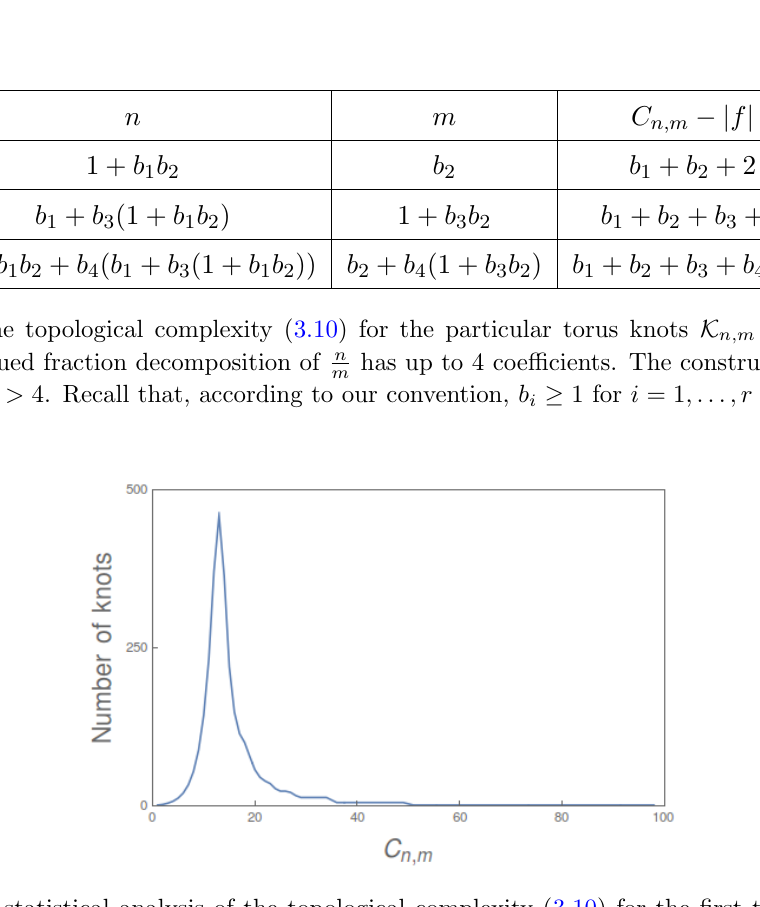
Figure 5. A statistical analysis of the topological complexity (3.10) for the (cid:12)rst three thousand torus knots (as told by their crossing number), ignoring the framing contribution. While the crossing number of knots in the sample reaches up to 10 4 , C n;m increases much more slowly, reaching a maximum of 100. In particular, the vast majority of states in the sample have moderate complexity (roughly between 10 and